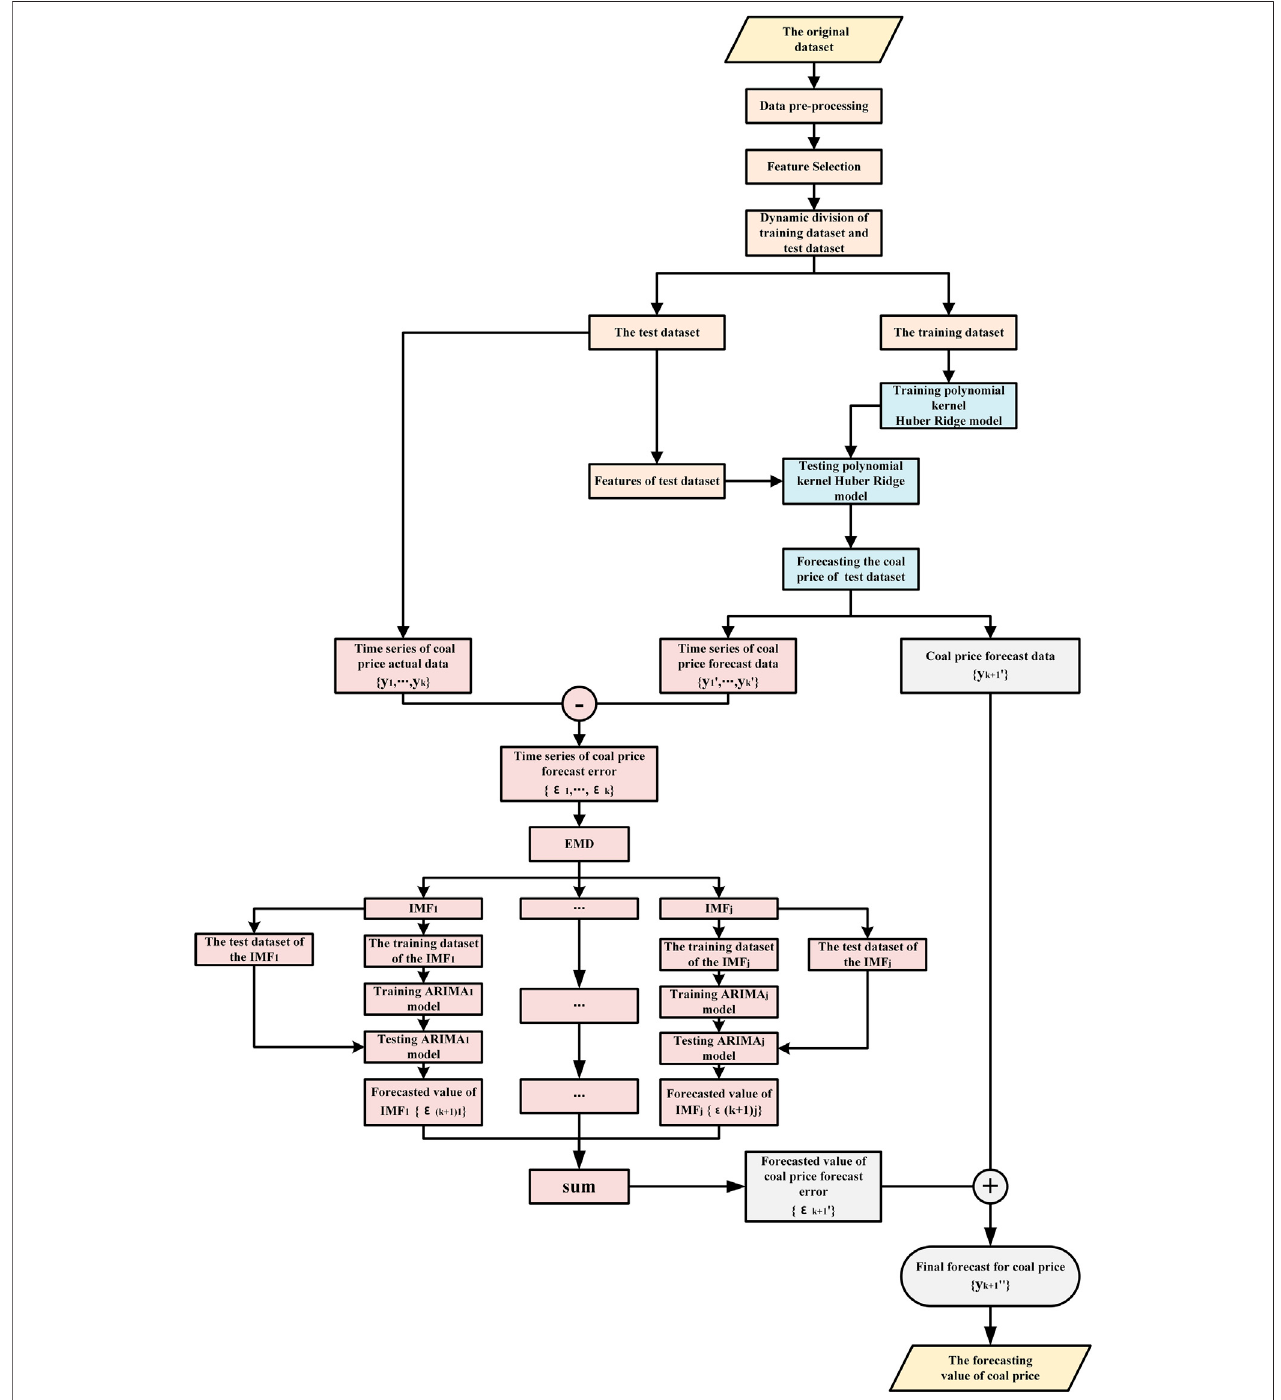
FIGURE 1 | Flowchart for training and forecasting of the PK – Huber – Ridge – EMD – ARIMA model.